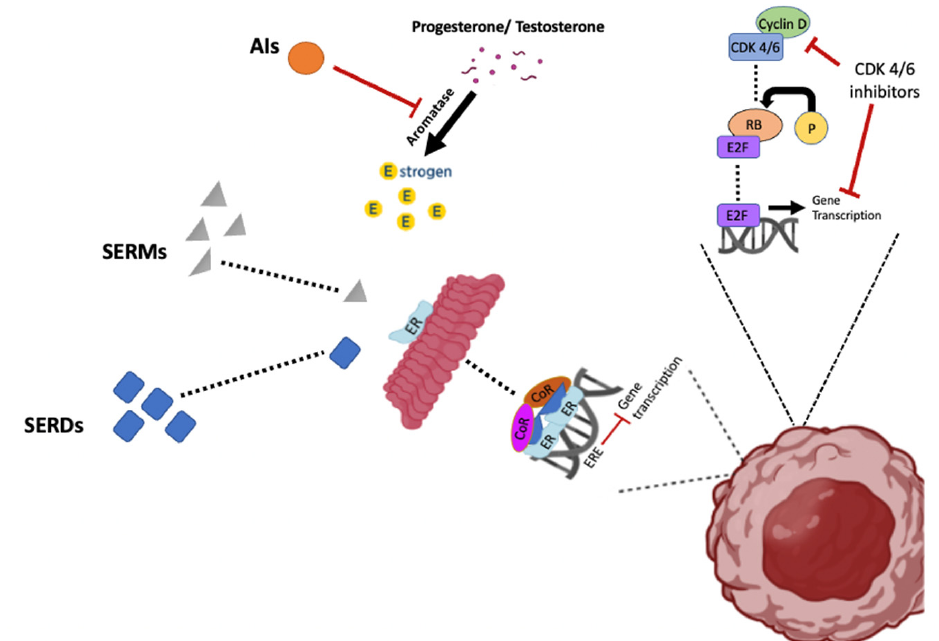
Figure 2. The effects of endocrine therapies (SERDs, SERMs, and AIs) and CDK 4/6 inhibitors on the ER pathway and gene transcription. SERDs block ER function by binding to the complex, resulting in degradation of the ER, SERMs prevent ER function by binding to ER to inactivate the complex, while aromatase inhibitors block ER function by inhibiting the synthesis of estradiol. CDK4/6 inhibitors prevent cell cycle progression by blocking the formation of CDK4/6 and cyclin D complex, which leads to the inhibition of gene transcription.